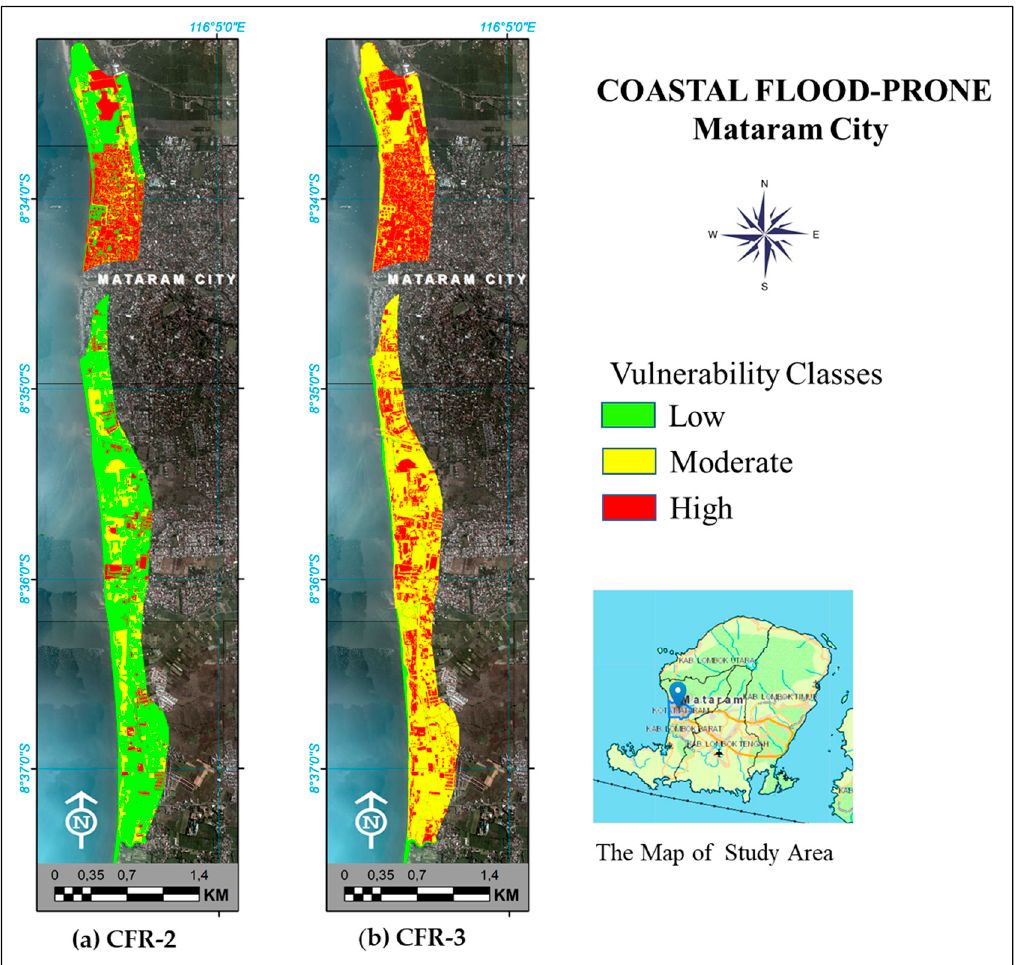
Figure 4. The result of CFR mapping based on CFR-2 ( a ) and CFR-3 ( b ). Table 3. Analytic hierarchy process (AHP) judgment matrix of the CFR-new-affecting parameters and consistency ratio assessment.